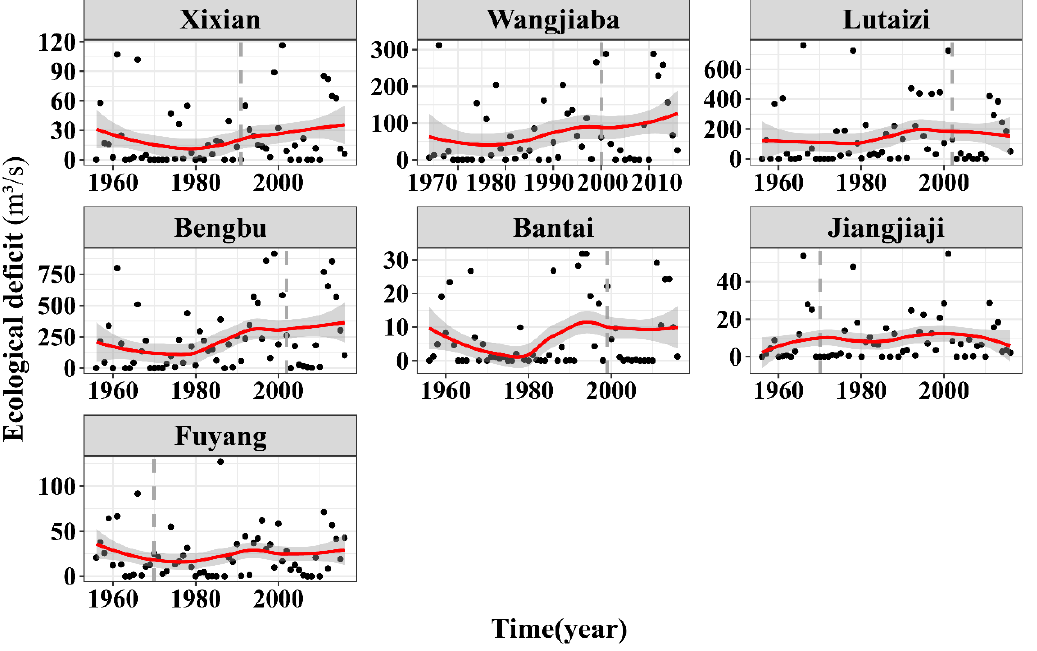
Figure 8. The trend change of the eco-deficit in the HRB.